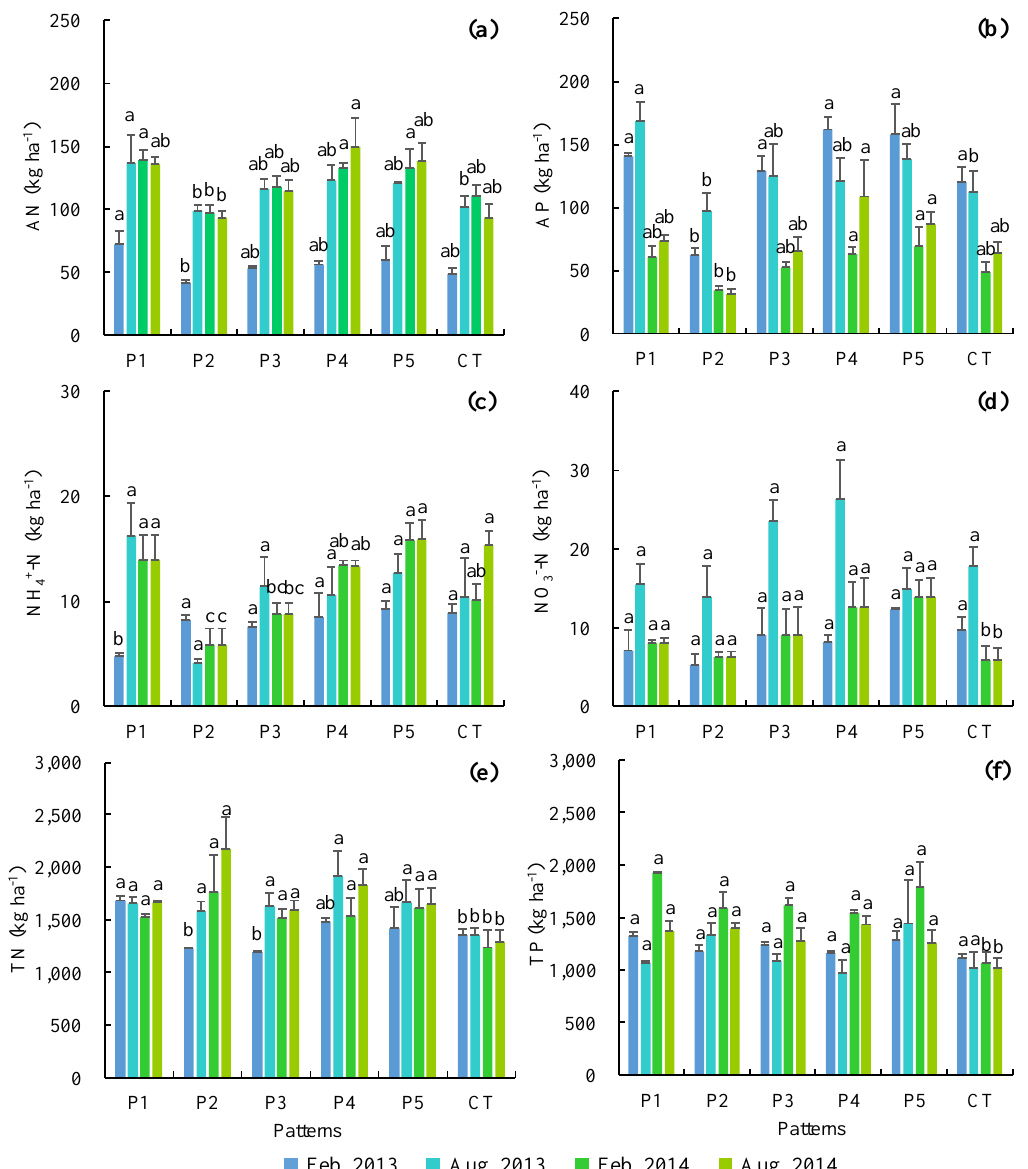
Figure 4. Soil buildup of available nitrogen (AN) ( a ), available phosphorous (AP) ( b ), NH 4 + –N ( c ), NO 3 − –N ( d ), total nitrogen (TN) ( e ), and total phosphorous (TP) ( f ) in the crop-mulberry systems on sloping farmland. The same letters above the bars indicate no significant di ff erence and di ff erent letters indicate significant di ff erences between these groups (p <